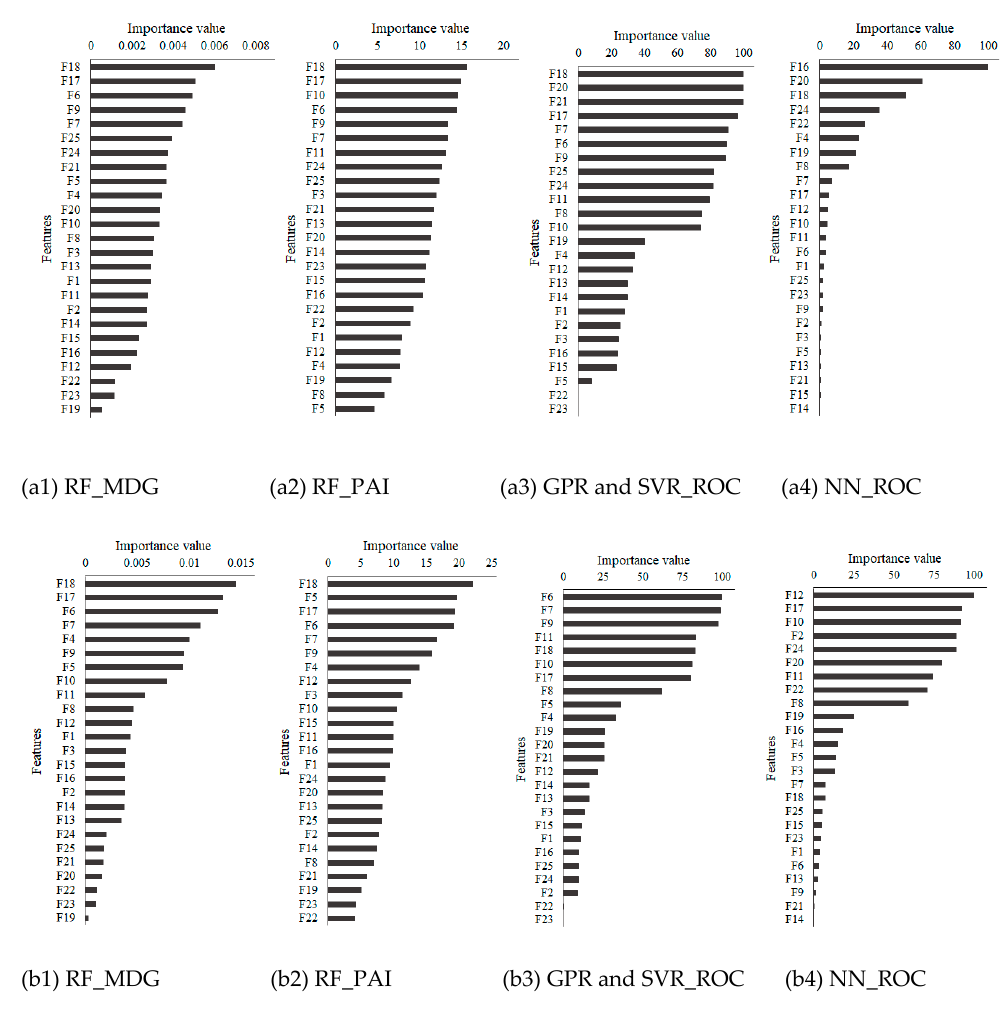
Figure 5. Relative importance for the variables of different applied models in Jiangxia ( a1 – a4 ) and Huangpi ( b1 – b4 ).